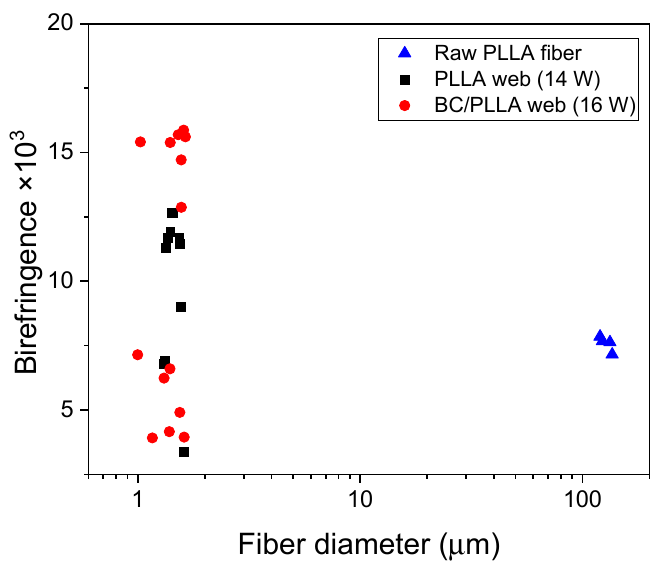
Figure 10. Correlation between the fiber diameter and birefringence of a raw PLLA fiber, an electrospun PLLA (14 W) web, and an electrospun BC/PLLA (16 W) web.